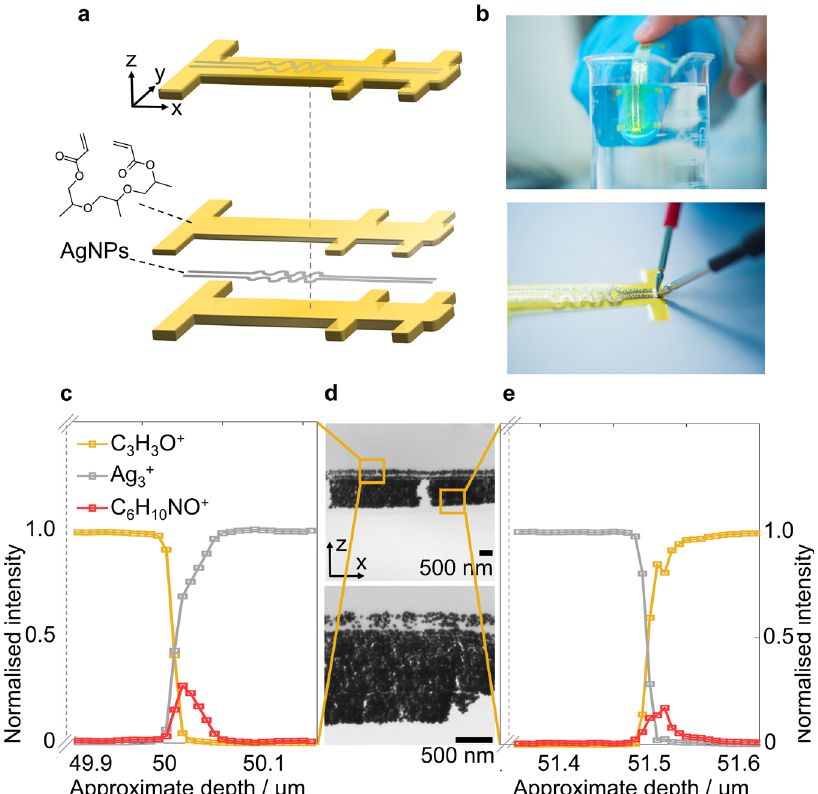
Fig. 5 Presence of residual stabiliser in a multi-material inkjet 3D printed encapsulated conductive silver pattern. a Schematic showing the layer structure of the device. b Photographs showing that encapsulation enables the use of the device under water. ToF-SIMS depth pro fi le results at the c top and e bottom interface. The dielectric material is TPGDA and represented by C 3 H 3 O + . PVP is represented by C 6 H 10 NO + d TEM micrographs of a cross-